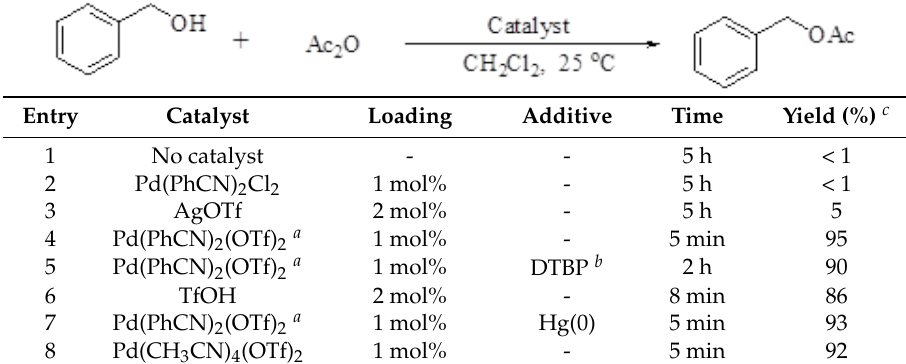
Table 5. A control experiment with benzyl alcohol as substrate.